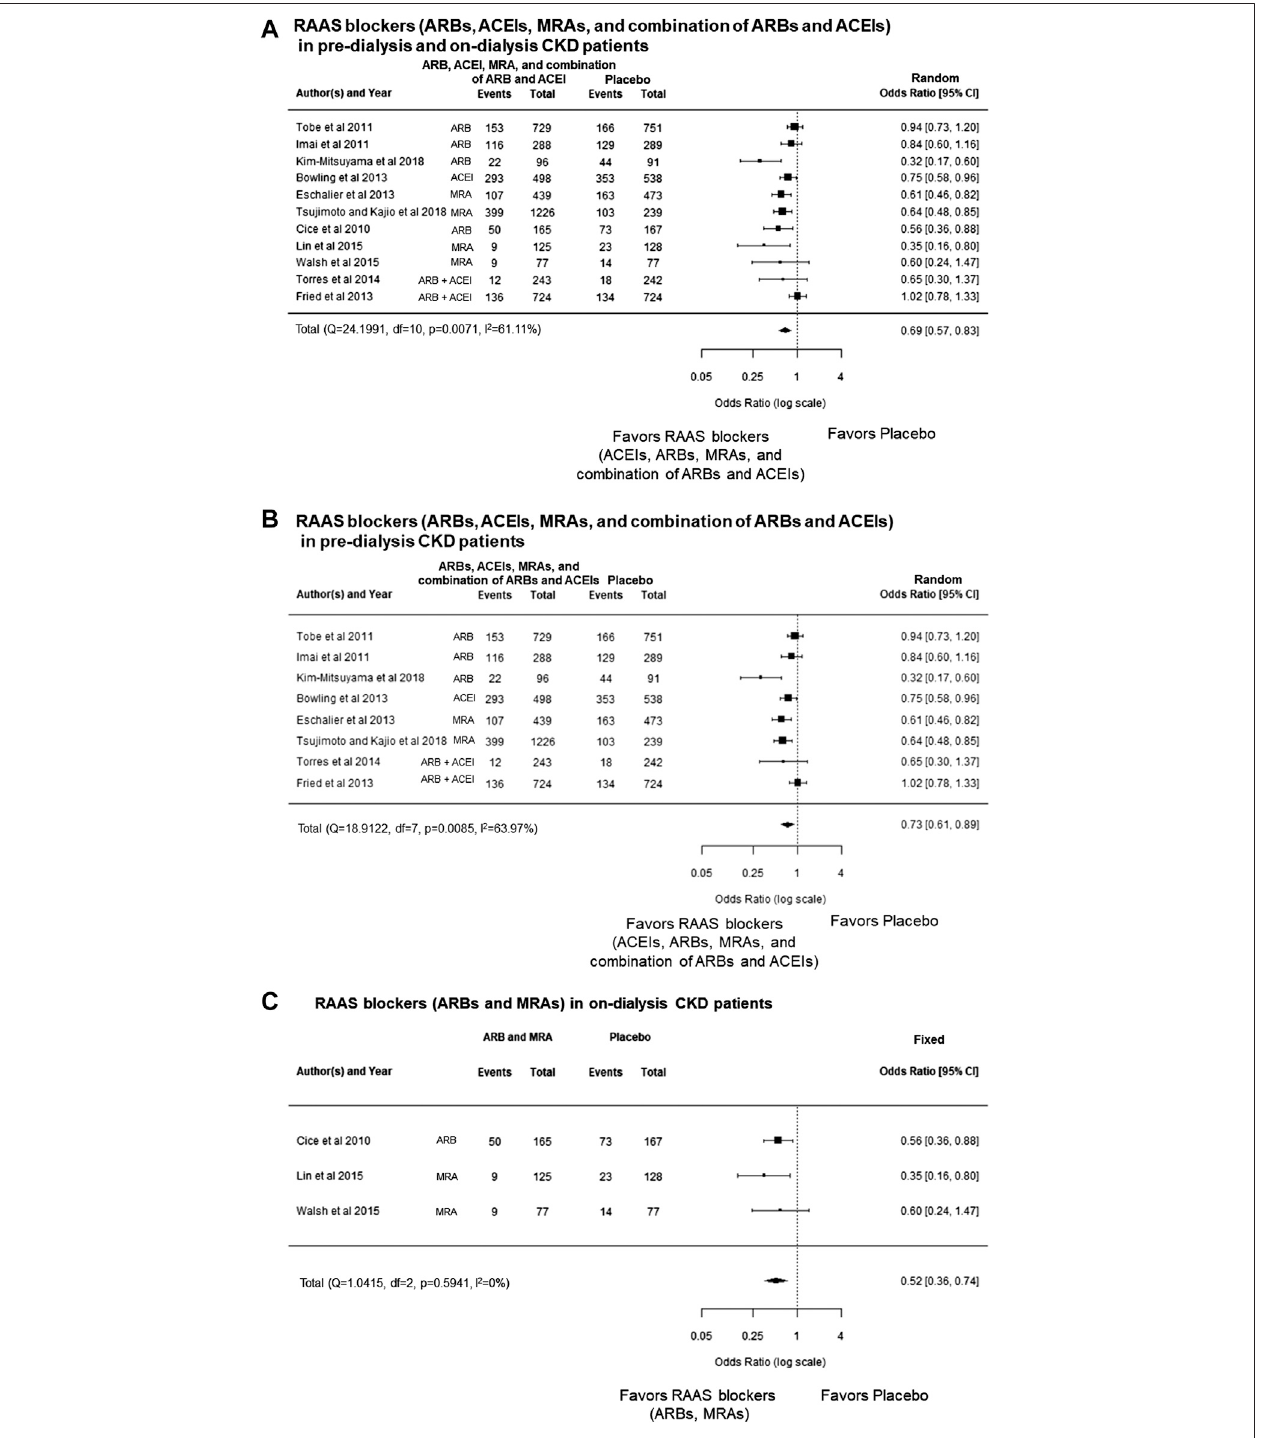
FIGURE2|(A) Forest plot describing acomparison oftheincidenceofcardiovascular eventsbetweenRAASblockers(ARBs, ACEIs, MRAs, and the combination of ARBs and ACEIs) and placebo in pre-dialysis and on-dialysis patients with CKD. (B) Forest plot describing a comparison of the incidence of cardiovascular events between RAAS blockers (ARBs, ACEIs, MRAs, and combination of ARBs and ACEIs) and placebo in pre-dialysis patients with CKD. (C) Forest plot describing a comparisonoftheincidenceofcardiovasculareventsbetweenRAASblockers(ARBsandMRAs)andplaceboinon-dialysispatientswithCKD.ACEIs,angiotensin converting enzyme inhibitors; ARBs, angiotensin receptor blockers; CI, con fi dence intervals; CKD, chronic kidney disease; MRAs, mineralocorticoid receptor antagonists; RAAS, renin – angiotensin – aldosterone system